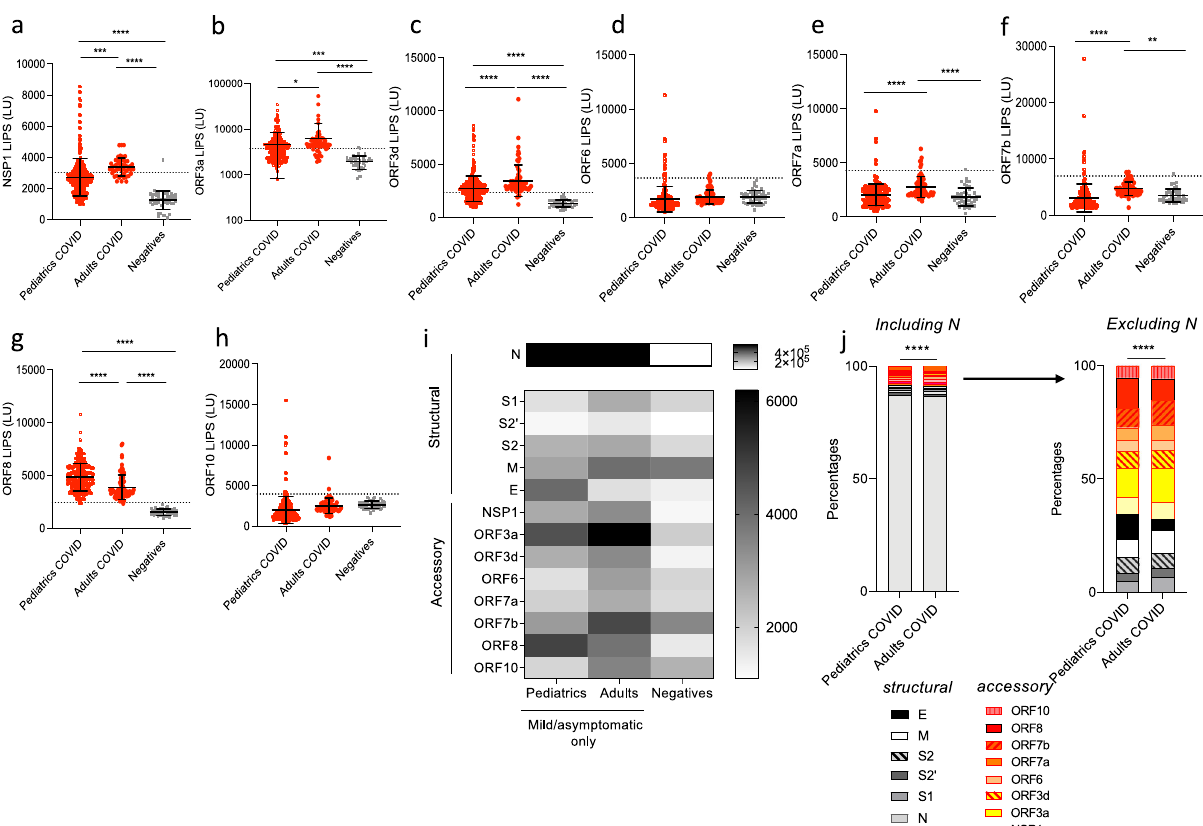
Fig. 2 Diverse distribution of antibody responses to single SARS-CoV-2 proteins in children and adults with asymptomatic/mild COVID-19. a – h Antibody levels to accessory proteins of SARS-CoV-2. Antibodies against NSP1 ( a ) (in ORF1ab), and other ORFs (ORF3a ( b ), ORF3d ( c ), ORF6 ( d ), ORF7a ( e ), ORF7b ( f ), ORF8 ( g ), and ORF10 ( h )) were measured in pediatric ( n = 254) and adult ( n = 71) COVID-19 cases and negative controls ( n = 48) by LIPS to cover all the ORFs of the virus. Signi fi cant p values for pediatrics versus adults are NSP1 ( a ) p = 0.0005, ORF3d ( b ) p < 0.0001, ORF7a p < 0.0001, ORF7b p < 0.0001, ORF8 p < 0.0001. Signi fi cant p values for pediatrics versus negatives are NSP1 ( a ) p < 0.0001, ORF3d ( b ) p < 0.0001, ORF7a p < 0.0001, ORF8 p < 0.0001, ORF10 p < 0.025. i , j Comparison of the antibody distribution in asymptomatic/mild children and adults. The cutoff value is shown by the dotted line and was based on the mean plus 3 × s.d. of the negative control group. i Heatmap comparing the mean concentrations (LU) for structural (N, S, S1, S2 ′ , S2, M, E) and accessory proteins (NSP1, ORF3a, ORF3d, ORF6, ORF7a, ORF7b, ORF10) responses in the COVID-19 pediatric, asymptomatic/mild adult populations (excluding severe cases) and negative controls. j Percentages of single antibody levels to SARS-CoV-2 antigens of the cumulative SARS-CoV-2 antibody response in COVID-19 children and asymptomatic/mild adults (excluding severe cases) for the antigen panel including and excluding N. The asymptomatic/mild pediatric and adult distributions were compared using a Chi-square test for expected versus observed distributions. Expected (adult) and observed (pediatric) percentages are detailed in Supplementary Table 3. P < 0.0001 for pediatric (observed) versus adult (expected) distribution of both antigen panels including N (left) and excluding N (right). Experiments were repeated twice. Two-sided P values were calculated using the Mann – Whitney U test. * shows statistical signi fi cance between COVID-19 patients versus negative controls. * p < 0.05, ** p < 0.01, *** p < 0.005, **** p < 0.0001. Data in ( a – h ) represents individual time point LIPS responses and the mean ± stdev, data in ( i ) represents mean values (LU), data in ( j ) represents only 4.72% overlapped with the ellipse of negative controls (Fig. 3g). Fig. 3 and Fig. 3d, e). Antibodies to accessory proteins ORF3d, Figure 3h and statistical comparison of the 2-dimensional NSP1, ORF3a, ORF8, ORF7a had high correlation values distributions of the pediatric and adult groups “ asymptomatics ” , “ mild ” , and “ severe ” revealed that the distribution of the population (Supplementary Table 2), re fl ecting that antibodies to structural proteins do not solely drive the principal component 1. of severe adult patients was signi fi cantly different than that of the adult mild or asymptomatic populations ( p = 0.027 for severe versus asymptomatic adult cases, and p = 0.011 for severe versus mild adult cases with the Kolmogorov – Smirnov test 36,37 . Overall, the PCA showed that adults with severe symptoms had a distinct PC value distribution than adults with mild symptoms (Fig. 3h), which may be driven by these differences in S1, S2 ′ , and ORF8.